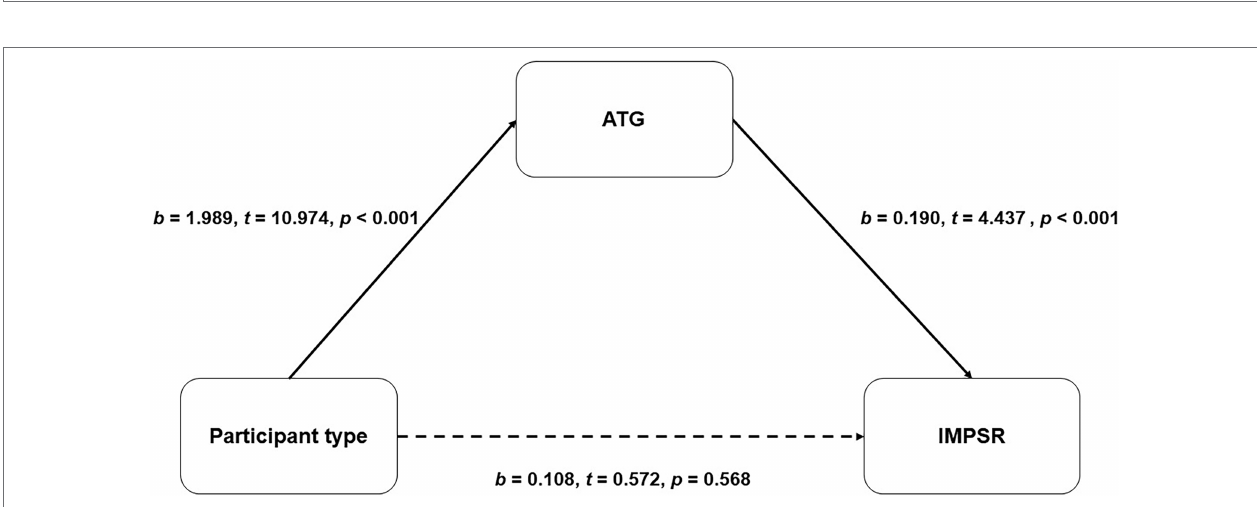
FIGURE 2 | The mediation effect of ATG between participant types and IMPSR for garners among male participants. ATG, attitude toward gaming; IMPSR, ideal marriage partners similarity rating.